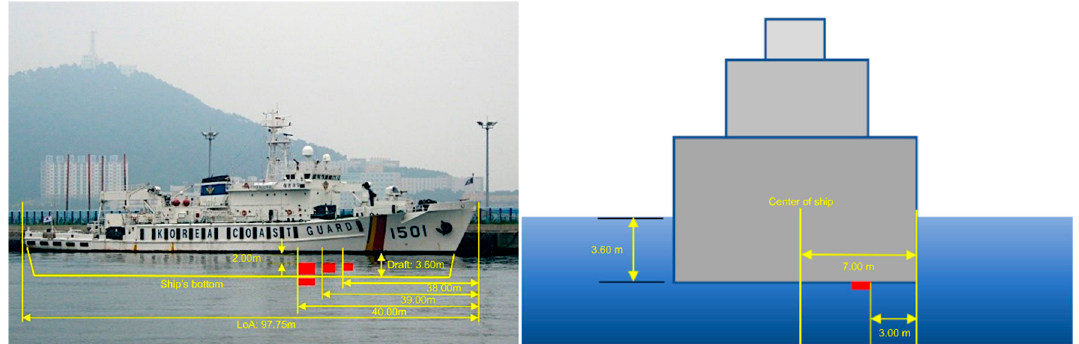
Figure 5. Conceptual representation of ship locations for the emergency magnetic liquid stop device attachment tests.